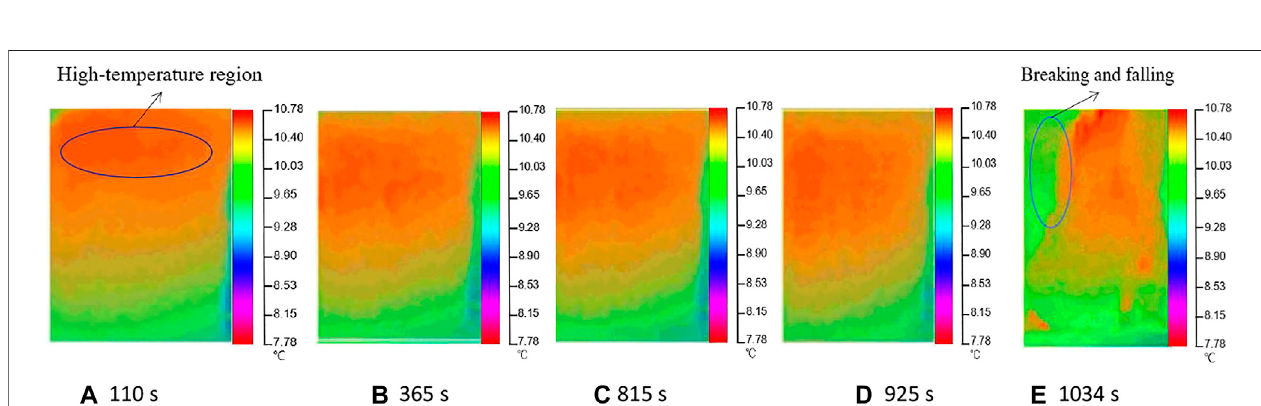
FIGURE 12 | Equalization treatment: compression of phosphate rock specimens loaded at 0.0005 mm/s. (A) 110 s, (B) 365 s, (C) 815 s, (D) 925 s, and (E) 1034 s.